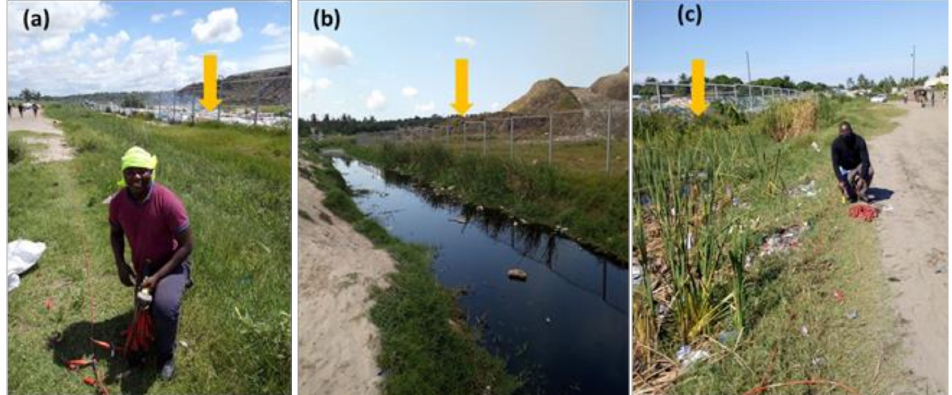
Figure 3. Geophysical surveys: ( a ) profile 1 in 2020—the arrow indicates the surface leachate concentration ditch parallel to the profile 1; ( b ) drainage ditch with uninsulated surface leachate 2021; ( c ) southern section of profile 1 in 2021.